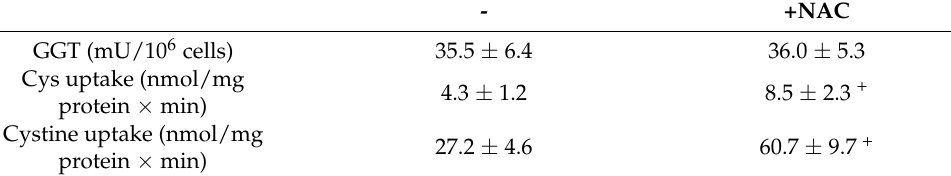
GGT Activity and Cyst(e)ine Uptake in B16-F10